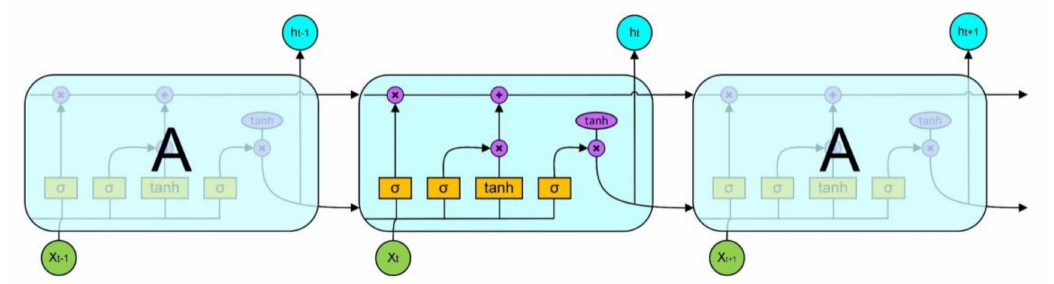
Figure 4. A basic LSTM network architecture for regression